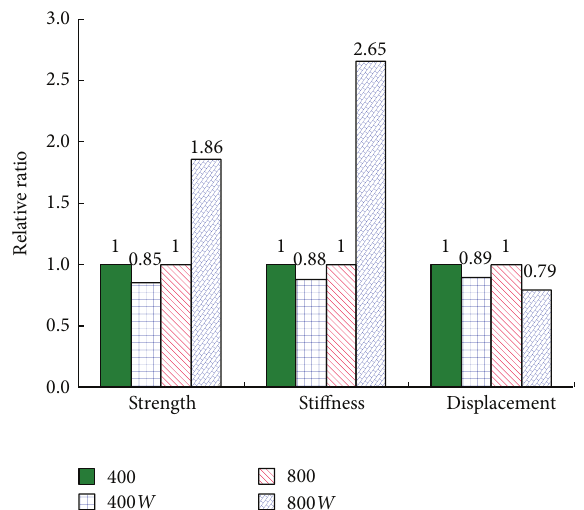
Figure 8: Influence of cooling regimes on compressive strength, stiffness, and displacement corresponding to peak load.